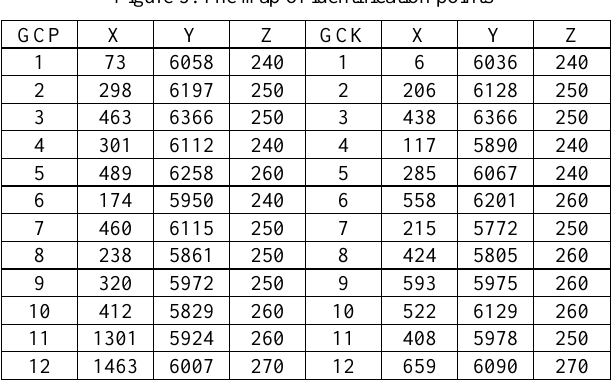
Figure 3. The map of identification